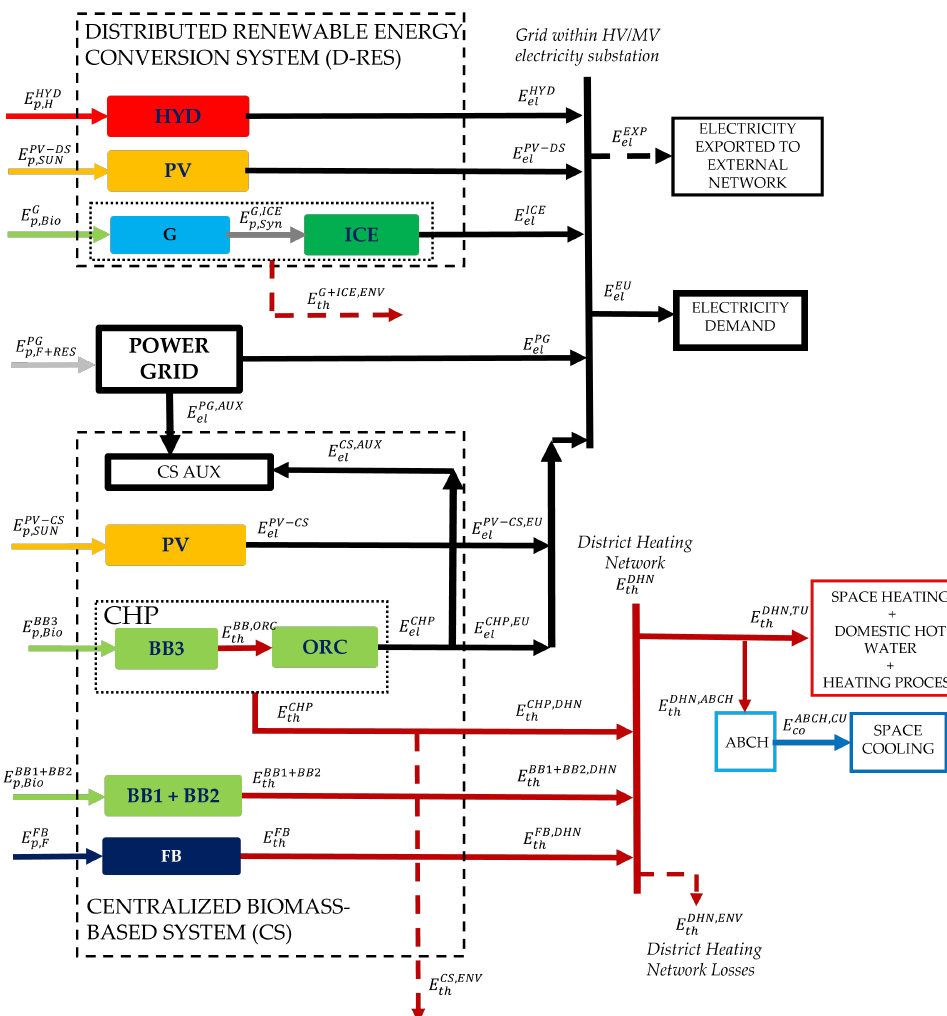
Figure 1. Energy conversion systems serving the DHN and the DS connected to the HV/MV substation serving the Municipality of